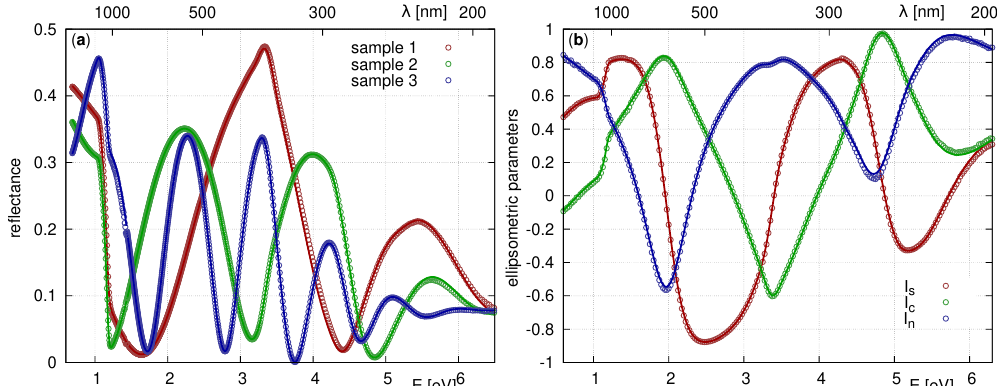
Figure 6. Spectral dependencies of reflectance of all three samples ( a ) and the associated ellipsometric parameters of Sample 1 at incidence angle 70 ◦ ( b ): points denote the measured values, curves denote the theoretical values.